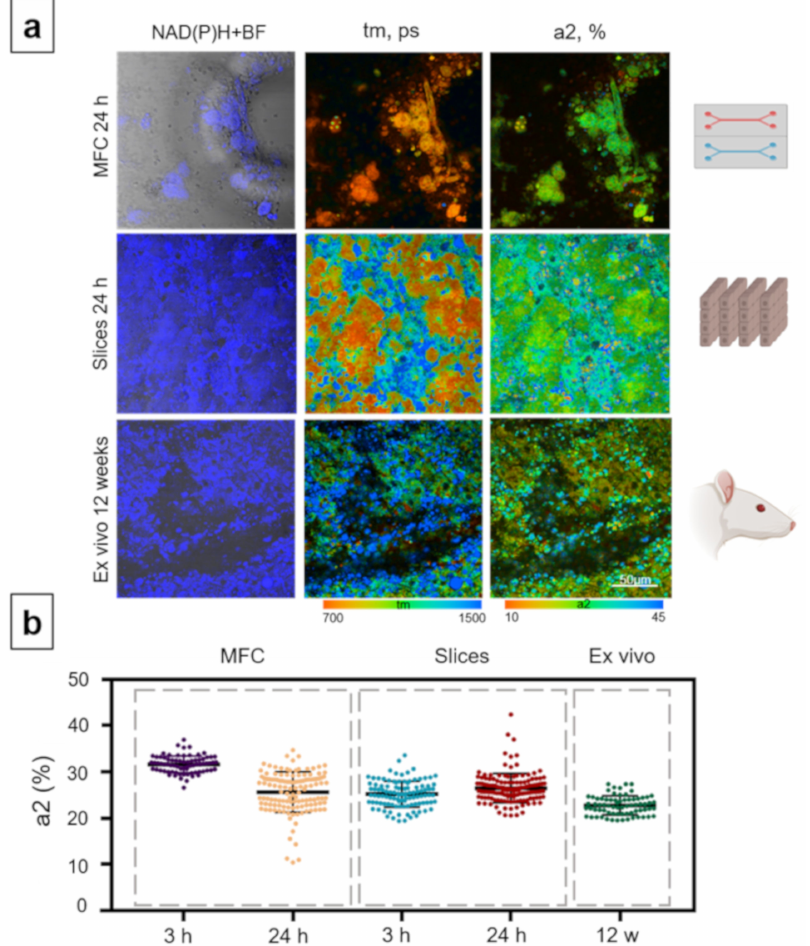
Figure 6. Metabolic imaging of rat hepatocytes exposed to ethanol in the MFC, slice and ex